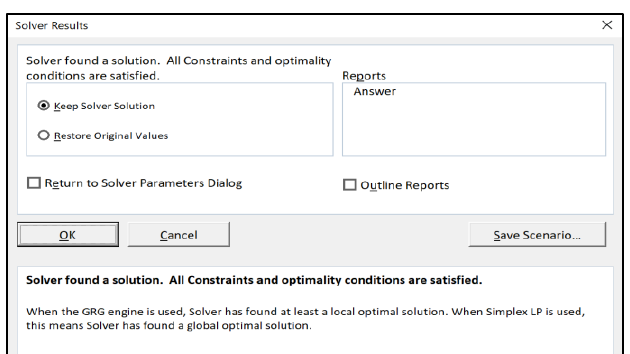
Fig. 2 . Solver results showing constraints are satisfied